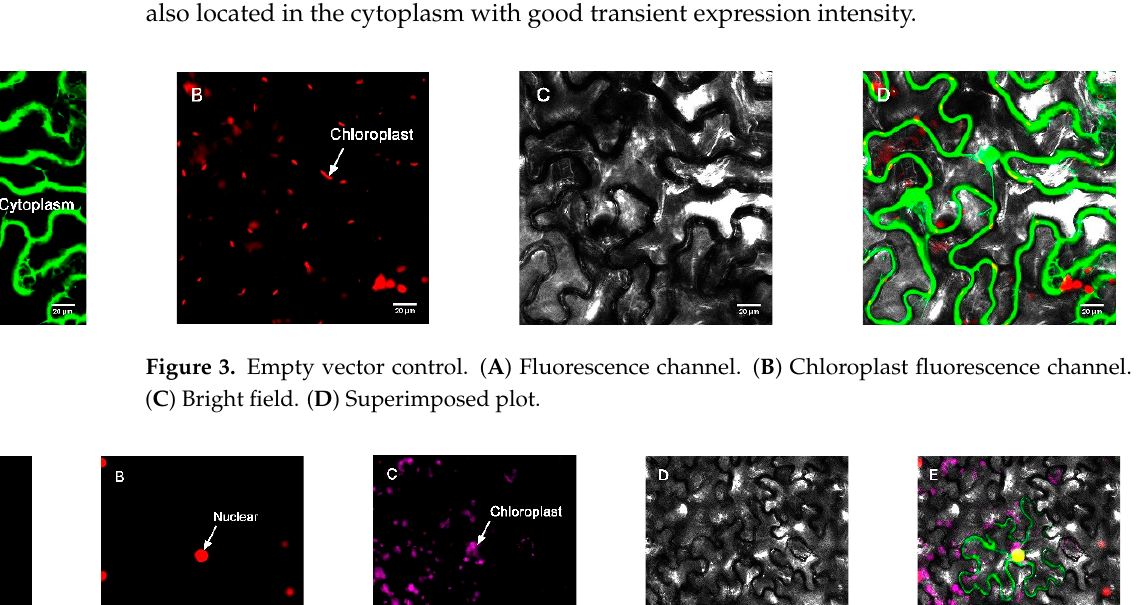
Figure 2. ( A ) Sequence alignment. ( B ) Phylogenetic tree.